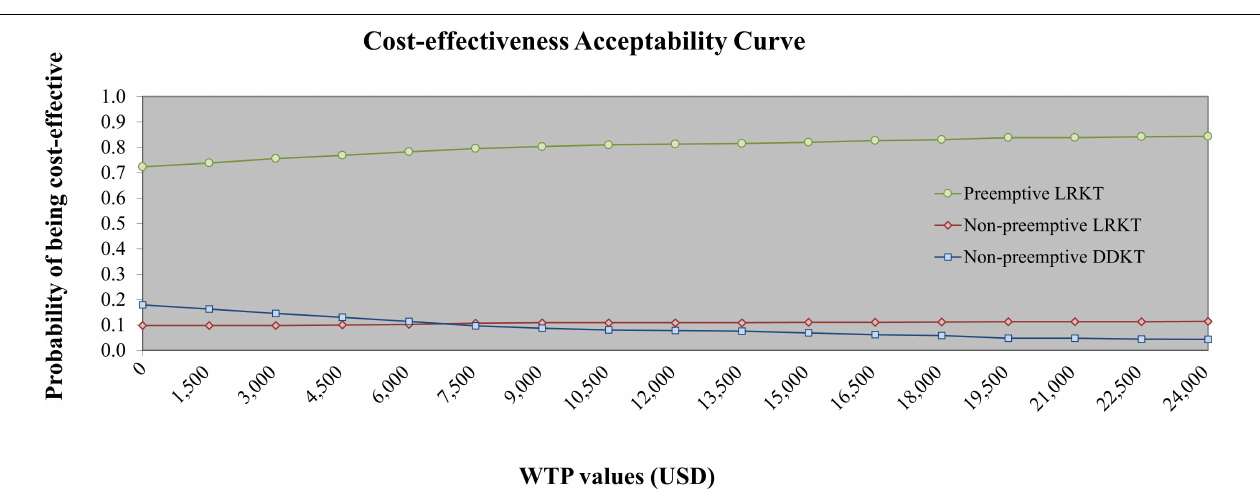
FIGURE 4 | Cost-effectiveness acceptability curve of preemptive LRKT, non-preemptive LRKT, and non-preemptive DDKT. DDKT, deceased-donor kidney transplantation; LRKT, living-related kidney